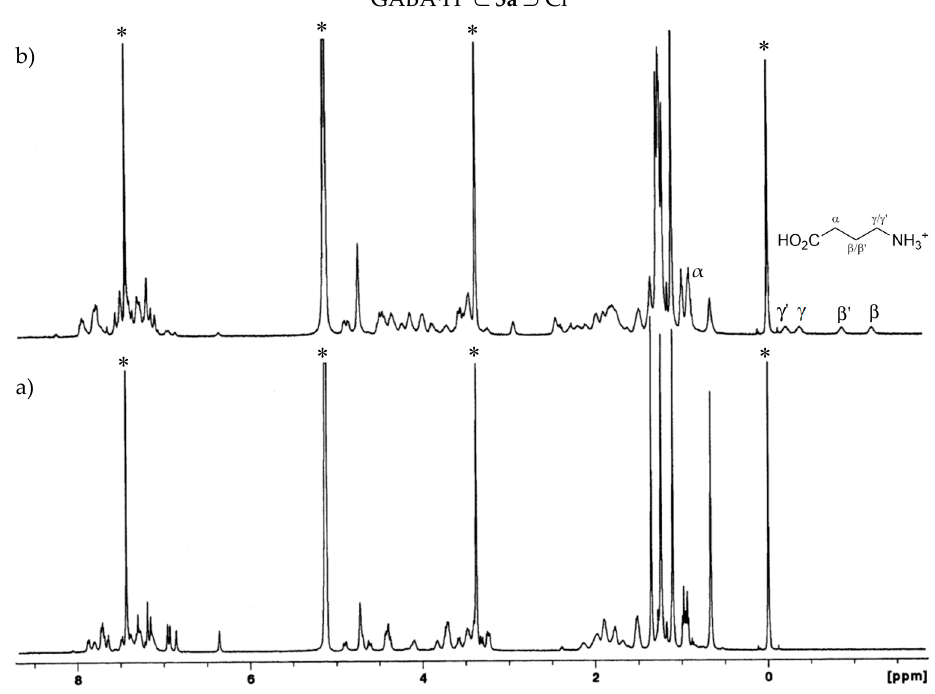
Figure 7. 1 H-NMR spectra (500 MHz, 233 K, CDCl 3 / CD 3 OD, 5:1, v / v ) of: ( a ) [ 5a ] = 1.0 mM; ( b ) [ 5a ] = [GABA · HCl] = 1 mM. * Denotes residual solvent signals.